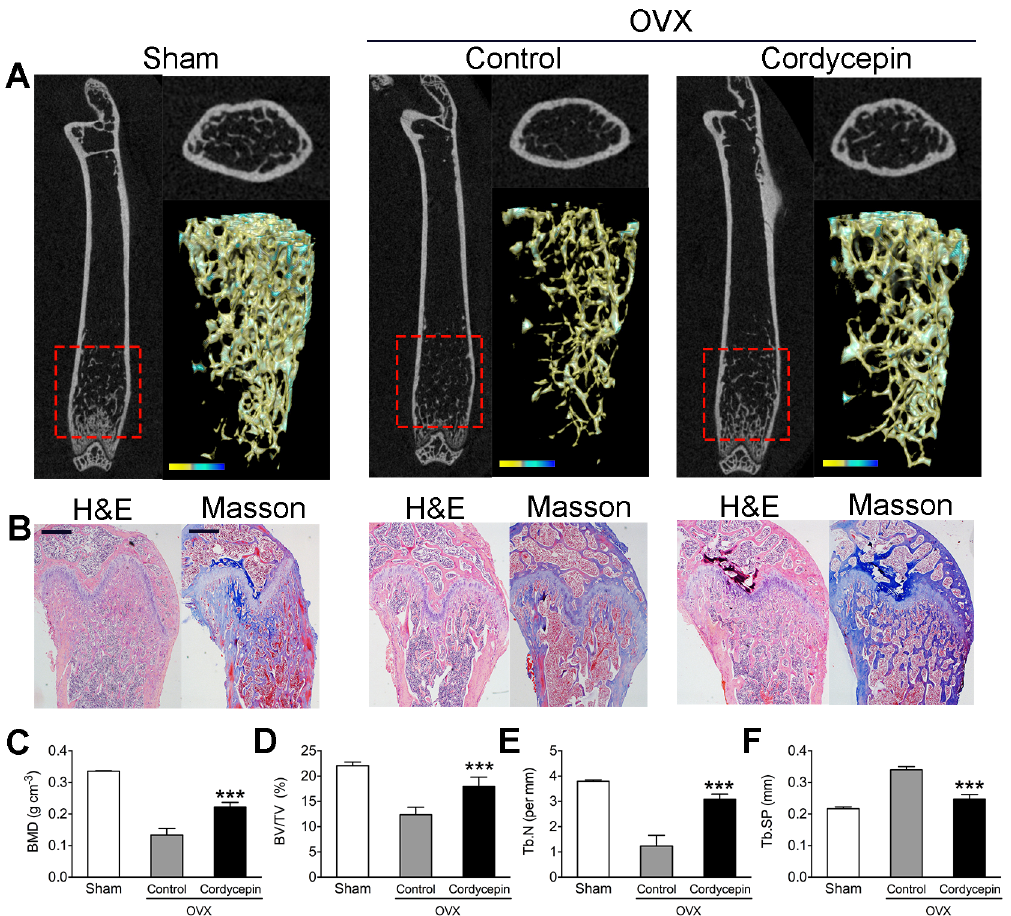
Figure 7. Cordycepin preventes bone loss in ovariectomized (OVX) mice: ( A ) Representative microCT longitudinal section images of femurs, cross ‐ sectional view of the distal femurs and reconstructed trabecular structure of the region of interest (red dashed box). Color scale bar represents bone mineral density level. ( B ) Representative images of histological slides of H&E stain and Masson stain focusing on the metaphyseal region of the distal femur from mice of different groups. Scale bar represents 800 μ m. ( C – F ) Quantitative microCT analysis of average femur length, distal femoral volumetric bone mineral density (BMD), trabecular bone volume fraction (BV/TV), trabecular number (Tb. N) and trabecular separation (Tb. Sp) in each group. Data in the figures represent average ± SD ( n = 3). *** p < 0.001 ( vs. Control) based on one way ANOVA.